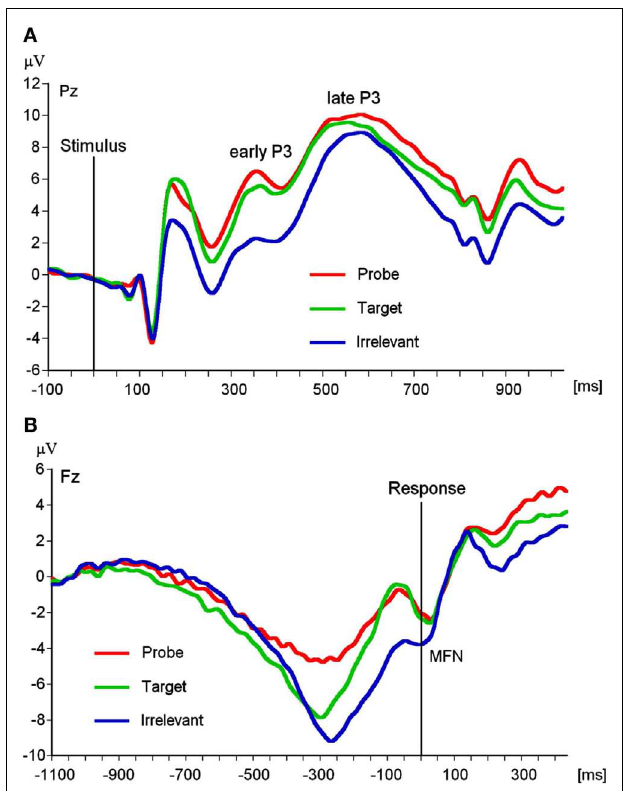
FIGURE 2 | (A) Stimulus-locked grand averages at Pz separated for Picture type ( N = 102). (B) Response-locked grand averages at Fz separated for Picture type ( N =